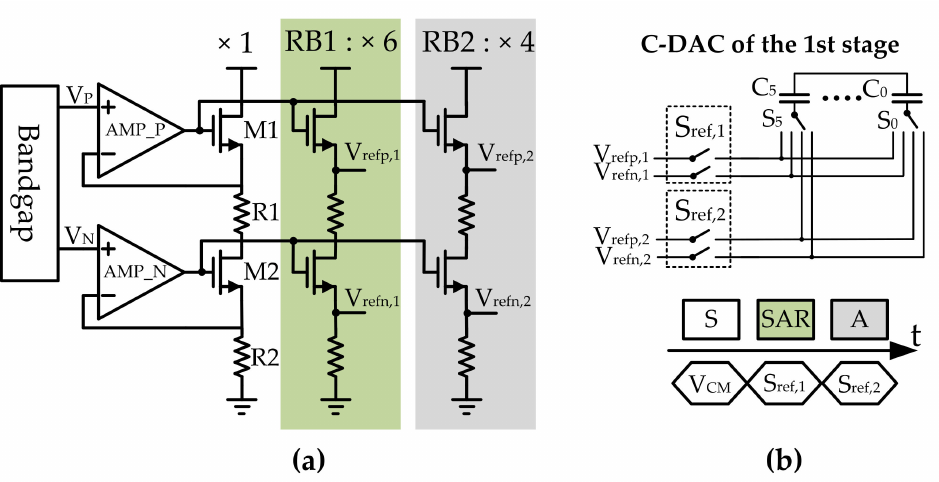
Figure 10. ( a ) The circuit implementation of the shared reference. The feedback loop with error amplifiers is on the left. Two references are marked with different colors. The number of branches is also annotated. ( b ) Implementation of the reference sharing in the 1st stage. The two pairs of switches for sharing are in the dashed box. The corresponding timing diagram is also drawn below, where S ref,1 is connected in the SAR phase and S ref,2 in the Amplification